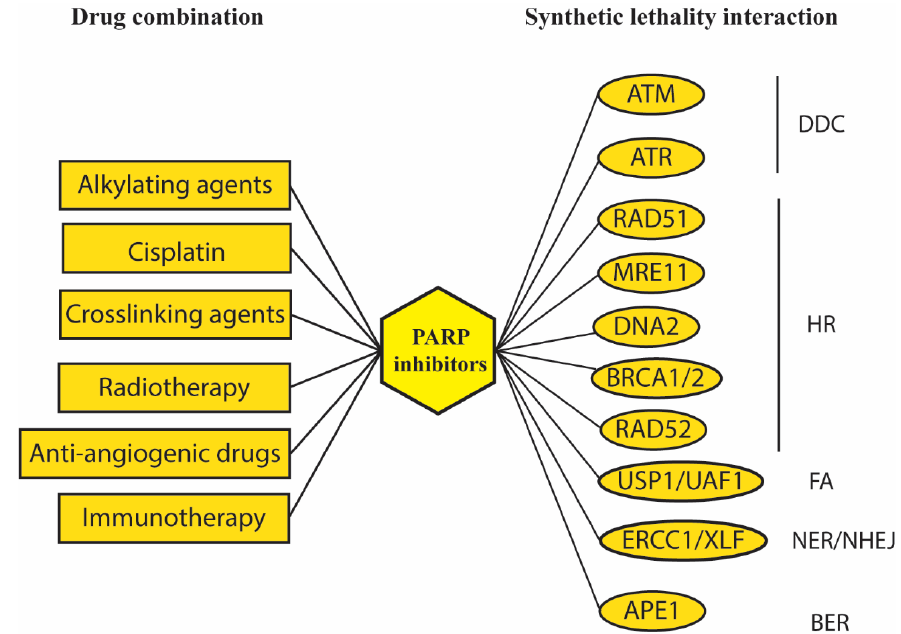
Figure 5. Field of PARP inhibitors in cancer therapy widely explored numerous